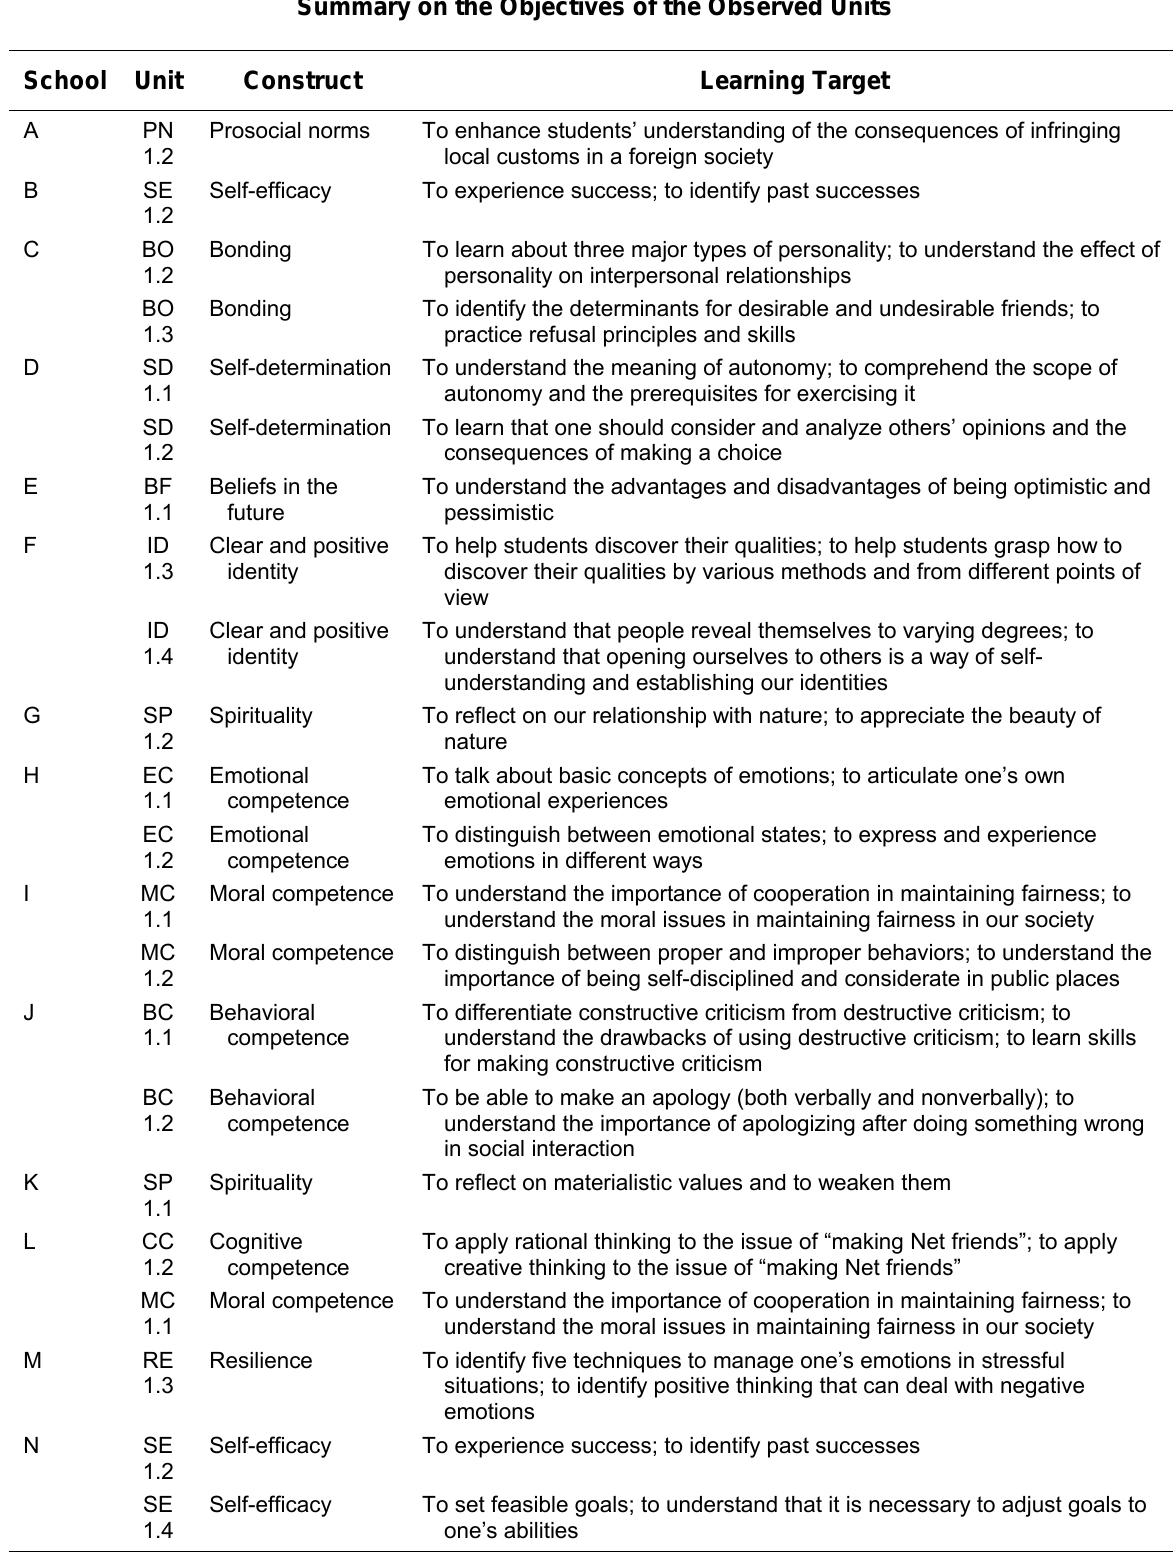
Summary on the Objectives of the Observed